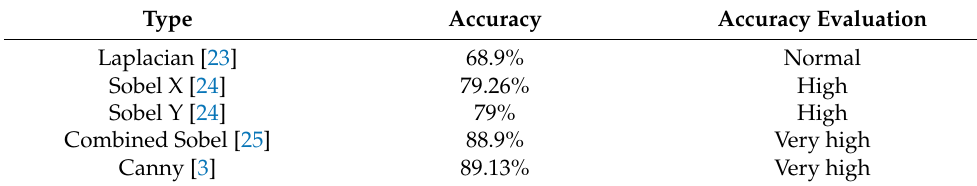
Table 2. Results of edge detection